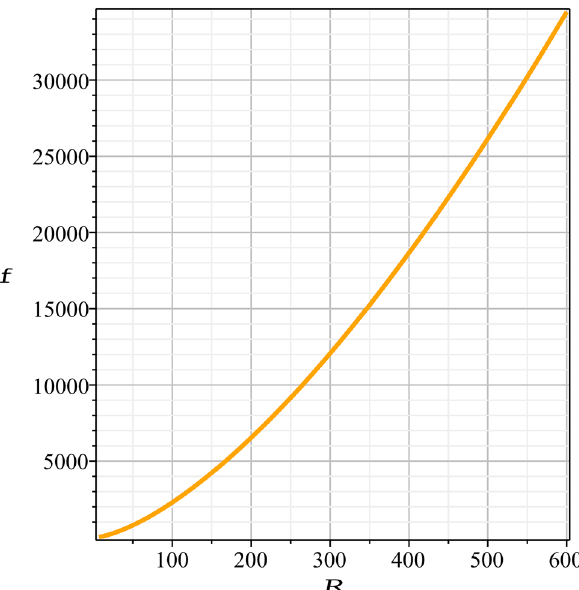
Fig. 3 This figure indicates the behavior of f ( R ) (obtained from numerical analysis) versus curvature R at curvature interval [ 7 , 600 ]